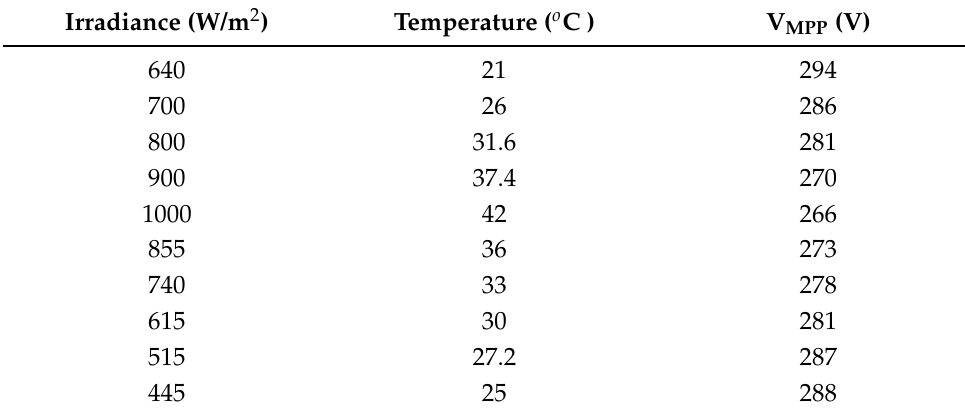
Table 1. Parameters of PV energy system.